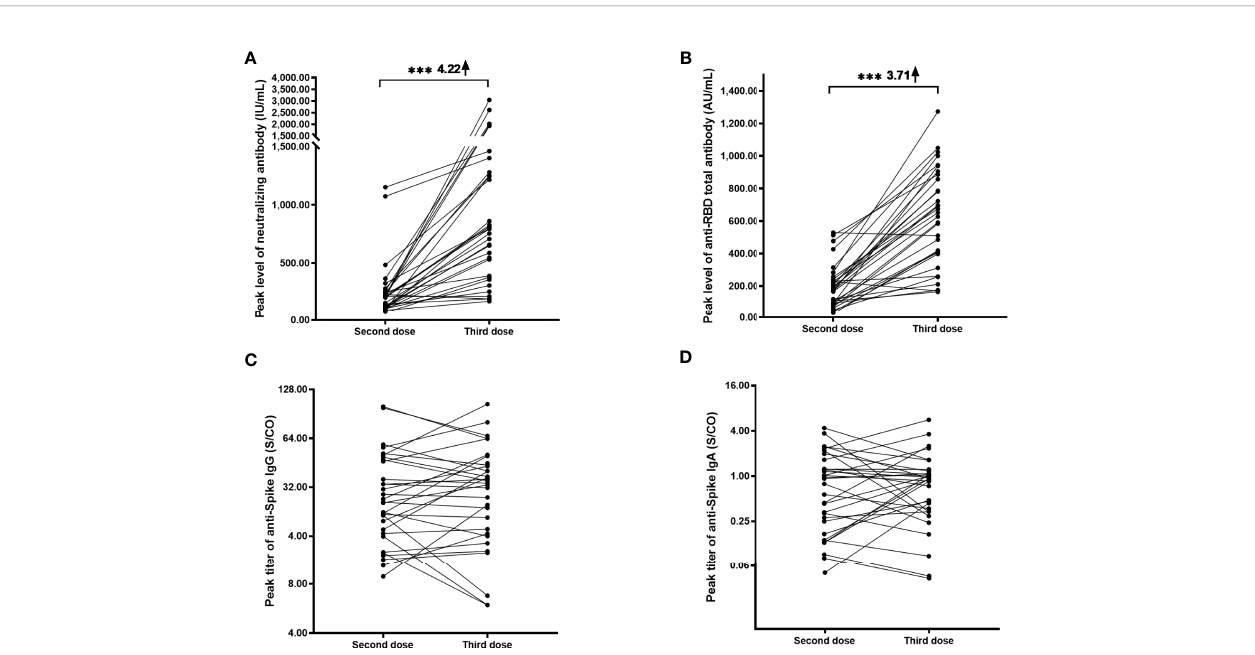
FIGURE 2 | Longitudinal responses of anti-SARS-CoV-2 antibodies after the second and third doses. Paired peak levels of neutralizing antibody (A) , anti-RBD total antibody (B) , anti-Spike IgG (C) , and anti-Spike IgA (D) after the second and third doses in a cohort of 32 participants. Because anti-spike IgM showed a minimal response after the third dose, the longitudinal responses failed to be drawn. *** P < 0.001.